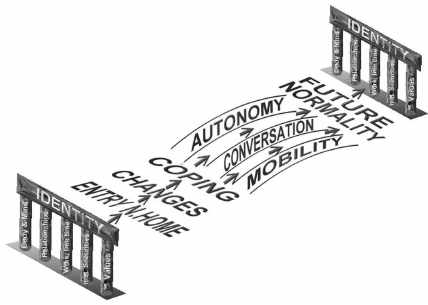
Figure 4: Entry into a nursing home and future identity (own